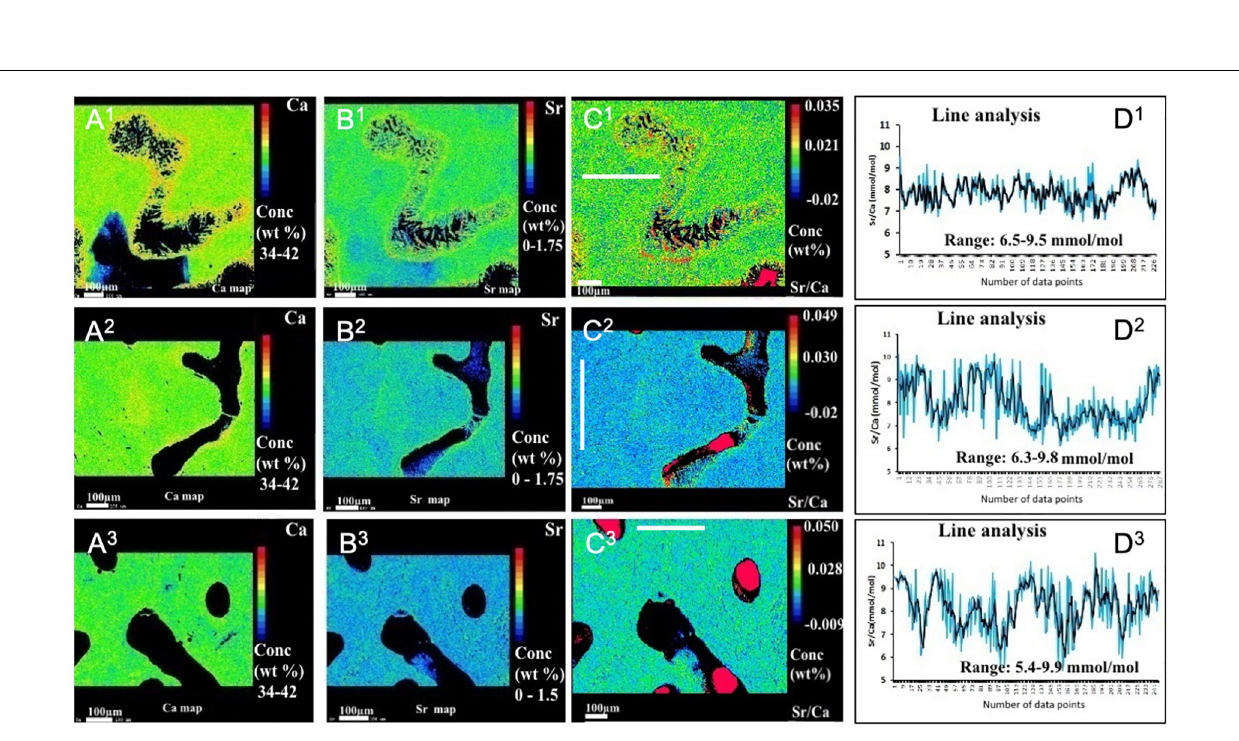
Frontiers in Earth Science | www.frontiersin.org